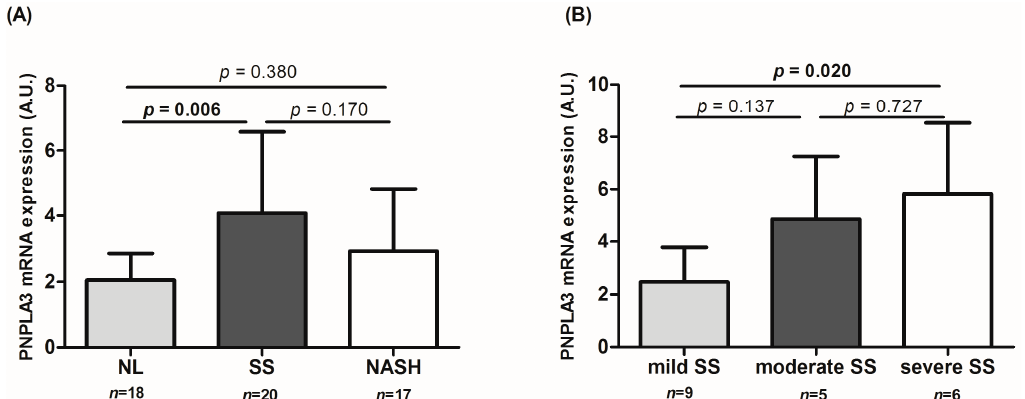
Figure 1. Hepatic expression of PNPLA3 gene in morbidly obese women according to the liver histopathology ( A ) and subclassifying the SS group into: mild, moderate, or severe SS ( B ). A.U.: arbitrary units; NASH: morbidly obese women with steatohepatitis; NL: morbidly obese women with a normal liver; SS: morbidly obese women with simple steatosis. ANOVA test was used to determinate differences between groups. p < 0.05 are considered statistically significant.